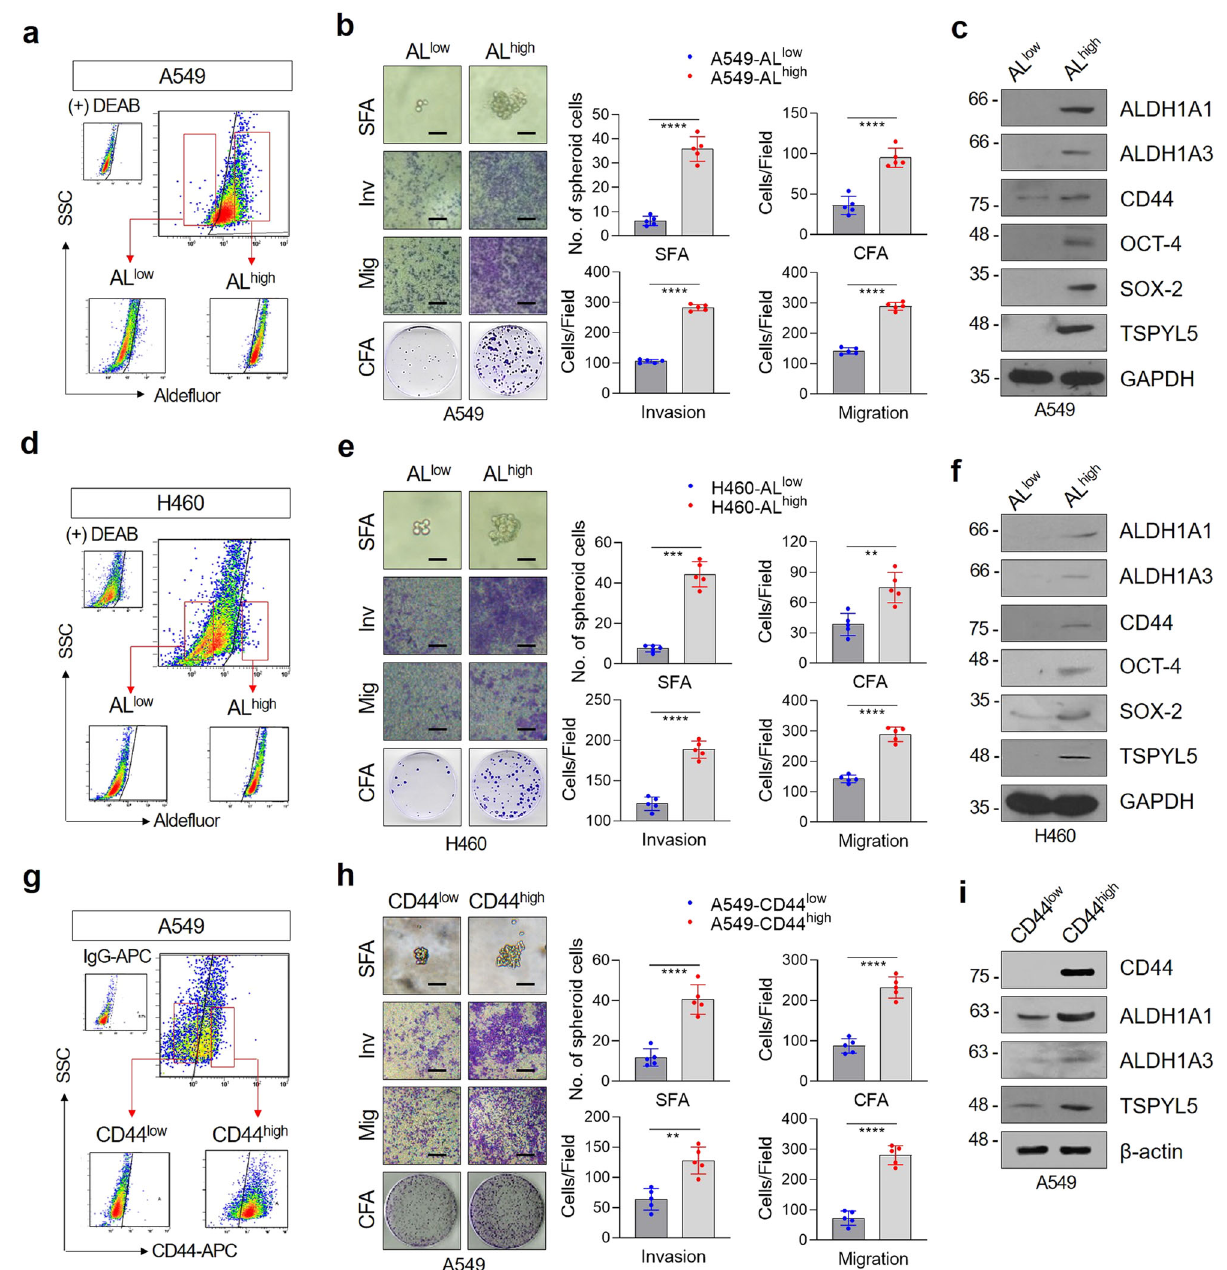
Fig. 2 The expressions of TSPYL5 and CD44 are elevated in ALDH1 high CSC-like cells isolated from NSCLC cells. a, d Flow cytometric analysis of CSC- like cells using Alde fl uor staining. A549 or H460 cells were stained with Alde fl uor substrate and sorted into ALDH1 low (AL low ) and ALDH1 high (AL high ) cells. Sorted cells were re-examined by Alde fl uor assay to con fi rm their ALDH1 activity. b, e Sphere formation, migration/invasion assay, and colony formation assay of AL low and AL high cells sorted from A549 or H460 cells. Scale bar: 20 μ m. c, f Western blot analysis of CSC markers (ALDH1A1, ALDH1A3, CD44, OCT-4, and SOX-2) and TSPYL5 in AL low and AL high populations sorted from A549 or H460 cells. g Flow cytometric analysis of CSC-like cells using anti-CD44 immunostaining. A549 cells were stained with APC-conjugated anti-human CD44 antibody and sorted into CD44 low and CD44 high cells. Sorted cells were re-examined by CD44 staining to con fi rm their CD44 expression. h Sphere formation, migration/invasion assay, and colony- formation assay of CD44 low and CD44 high cells sorted from A549 cells. i Western blot analysis of CSC markers (ALDH1A1, ALDH1A3, and CD44) and TSPYL5 in CD44 high and CD44 low cells sorted from A549 cells. Data represent mean ± s.d. using two-tailed t -test. n = 5 independent experiments for each group. * p < 0.05, ** p < 0.01, *** p < 0.001, **** p <